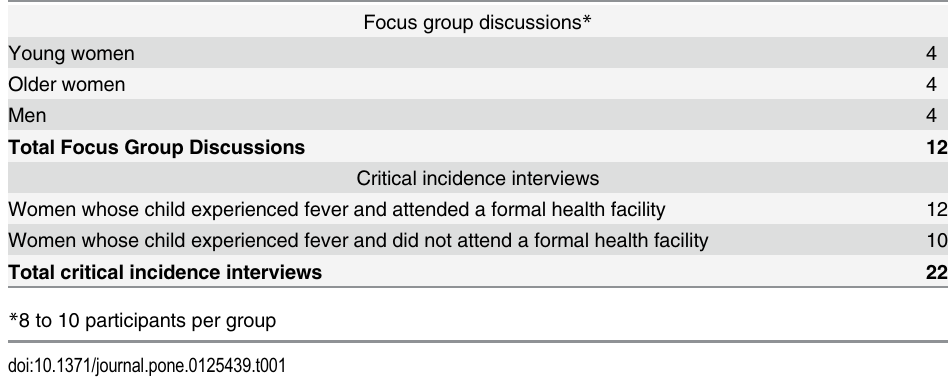
Table 1. Qualitative